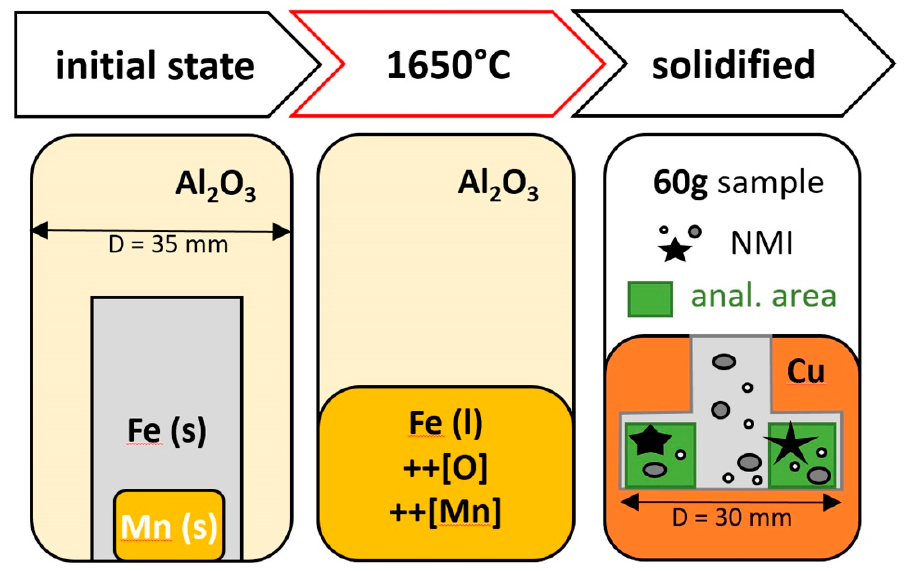
Figure 2. Schematic overview of different states during sample production.